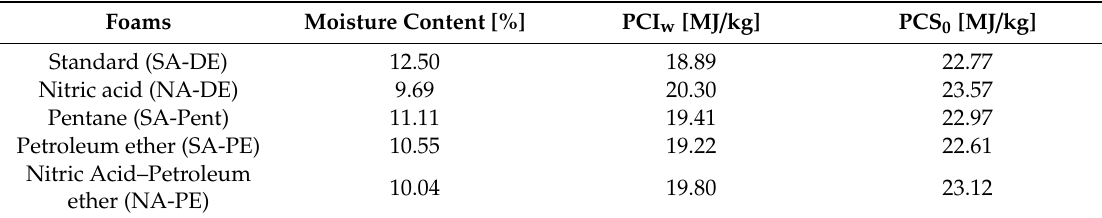
Table 3. Moisture content and heating values of the powdered